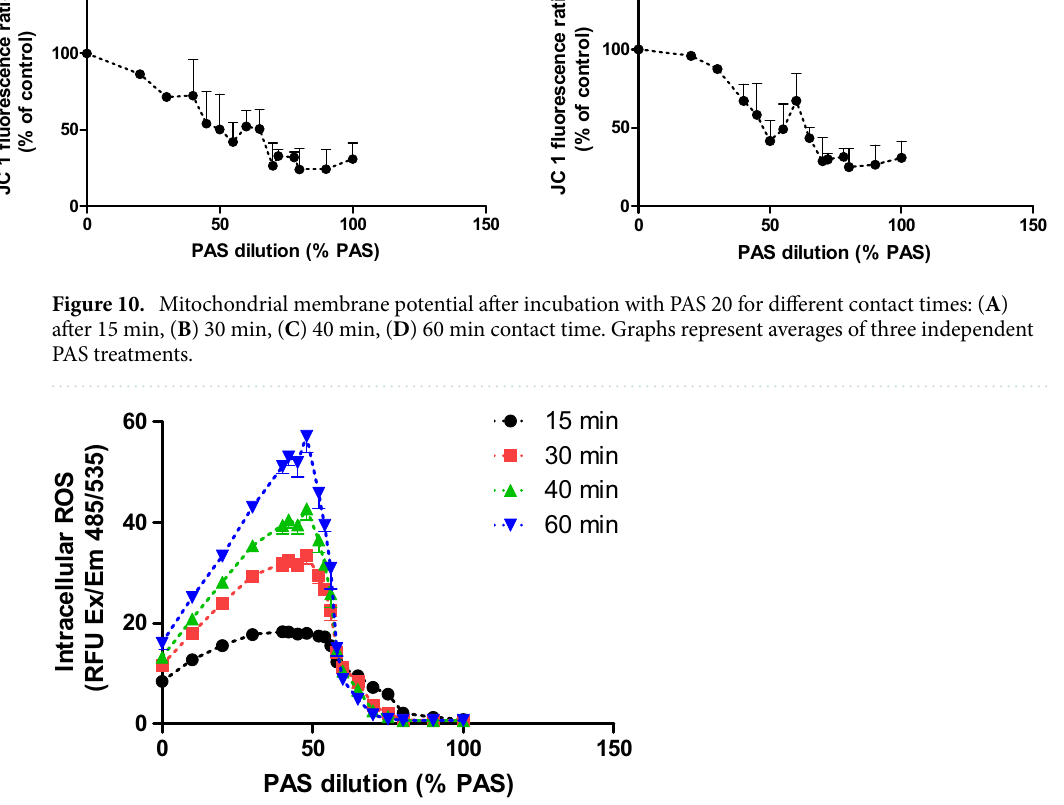
Figure 11. Detection of intracellular ROS after incubation of HaCaT with PAS 20 at different contact times. One representative experiment is represented.